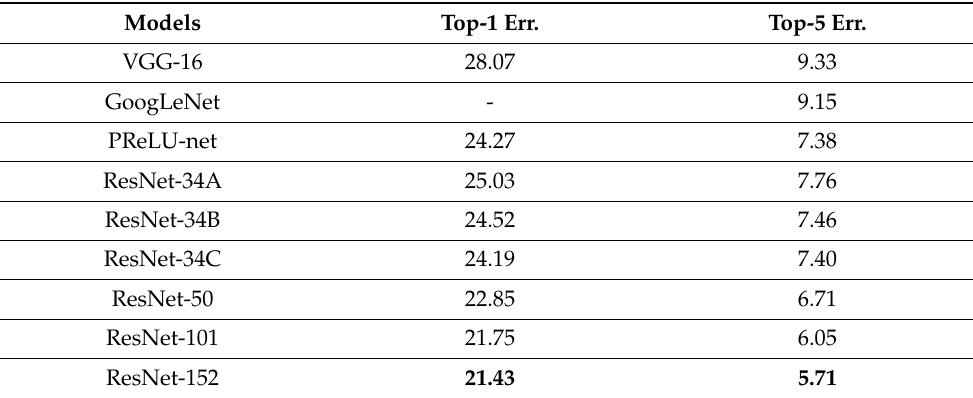
Table 3. Comparison of error rates for nine models.